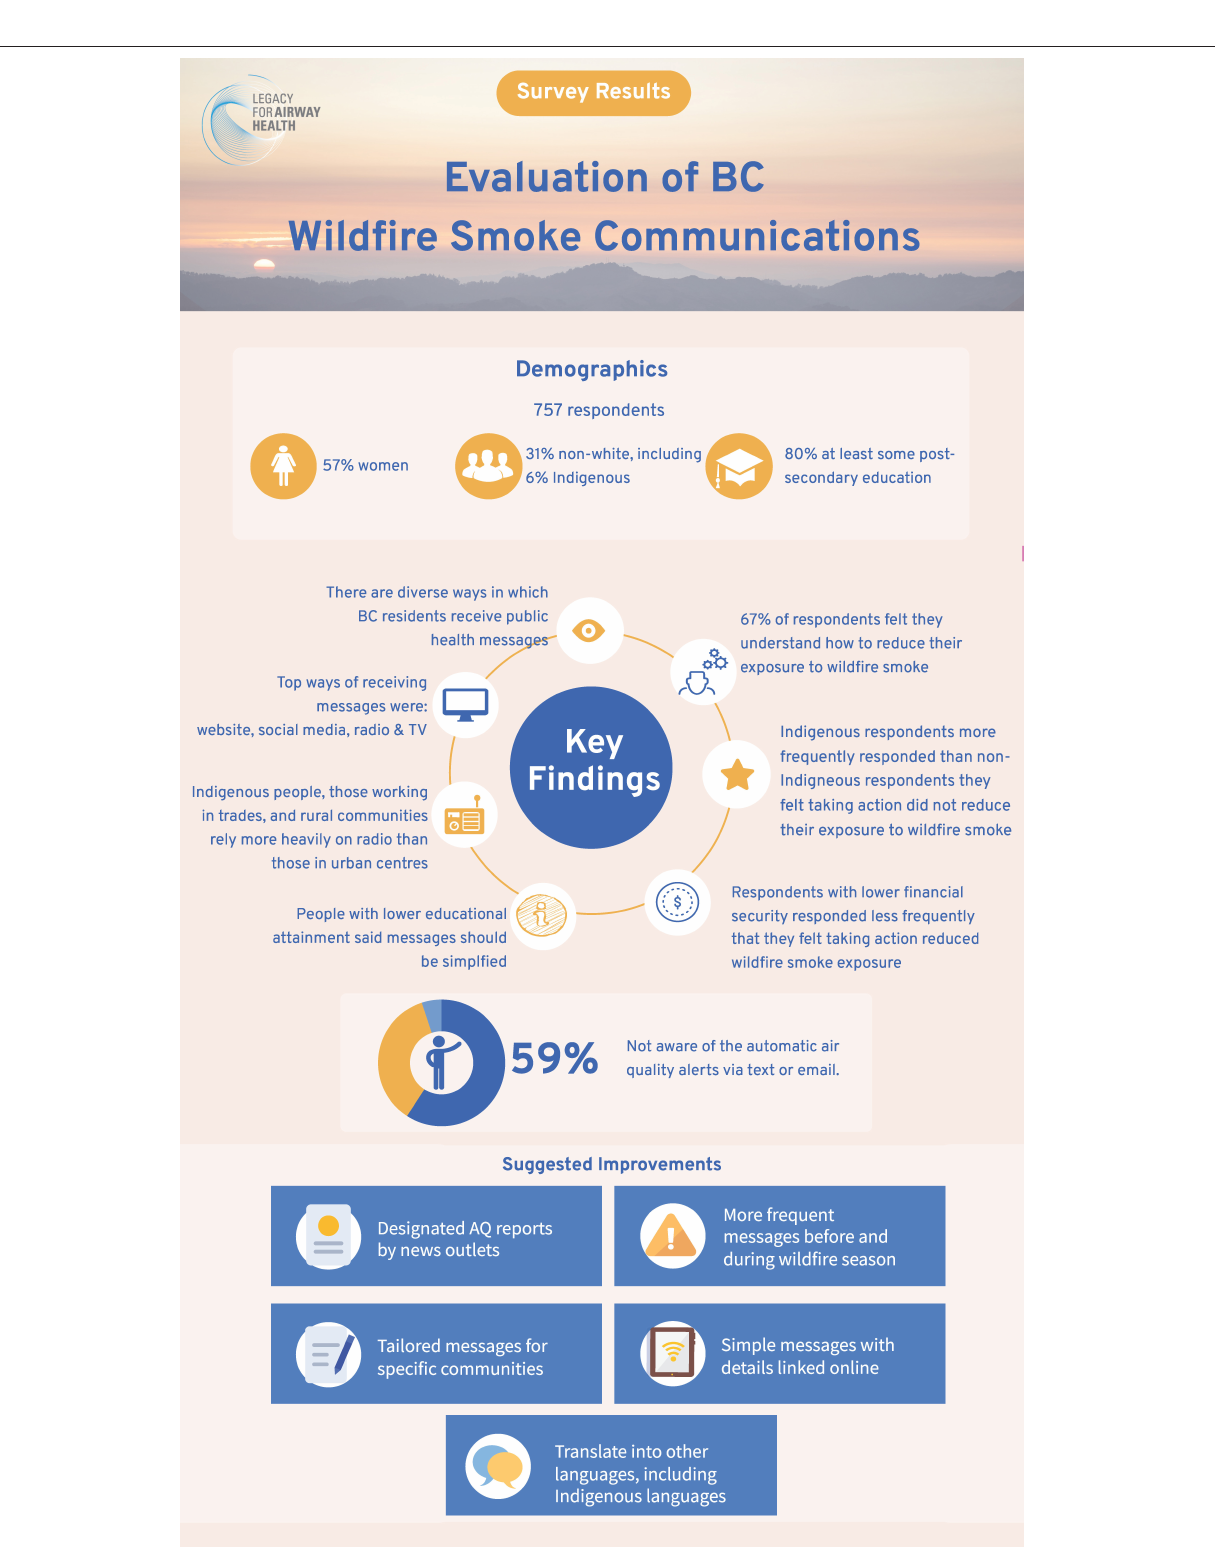
Frontiers in Public Health |